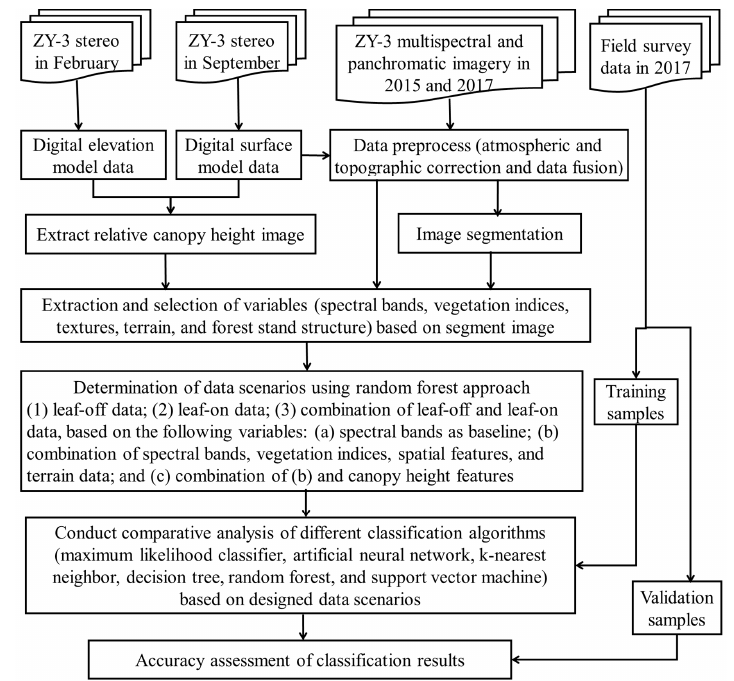
Figure 4. Framework of mapping land cover, forest, and tree species distribution through a comparative analysis of classification results using different classification algorithms based on various scenarios from ZiYuan-3 (ZY-3) data.